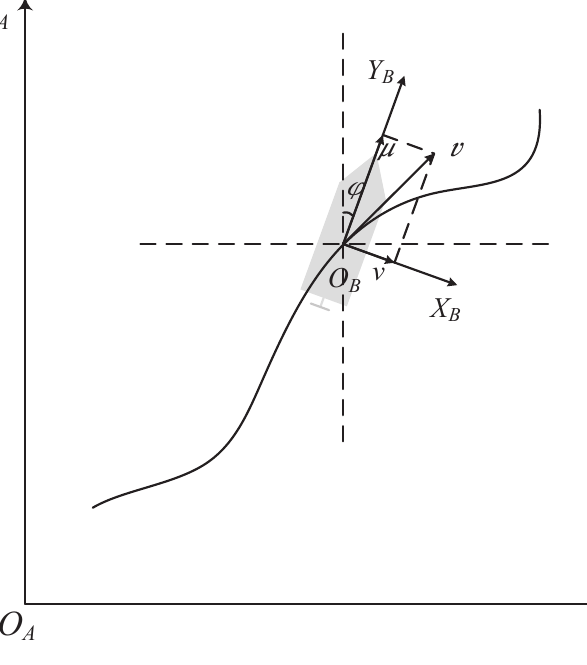
Figure 1. USV hull and inertial coordinate